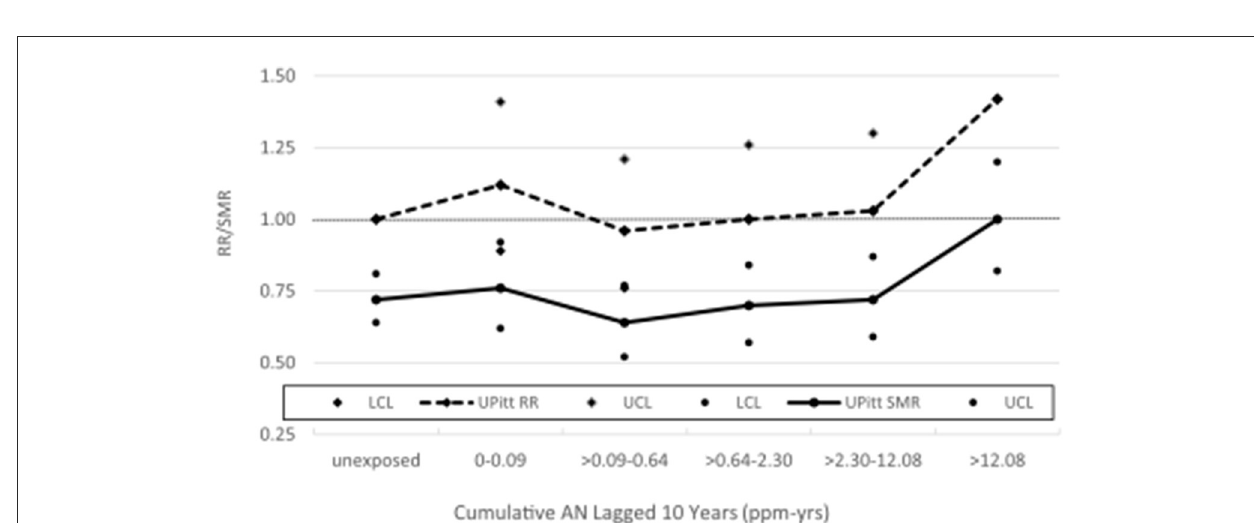
FIGURE1 UPitt lung cancer relative risks (RR) and regional rate-based SMRs by cumulative AN exposure.